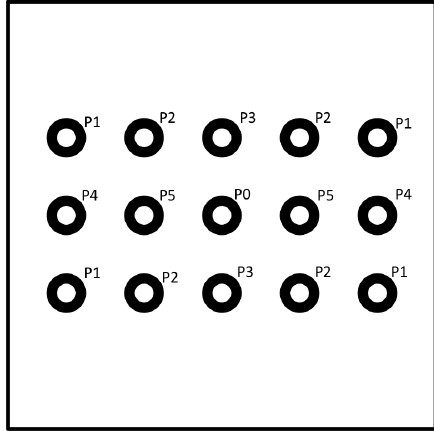
Figure 4. The used grouping scheme for target points during